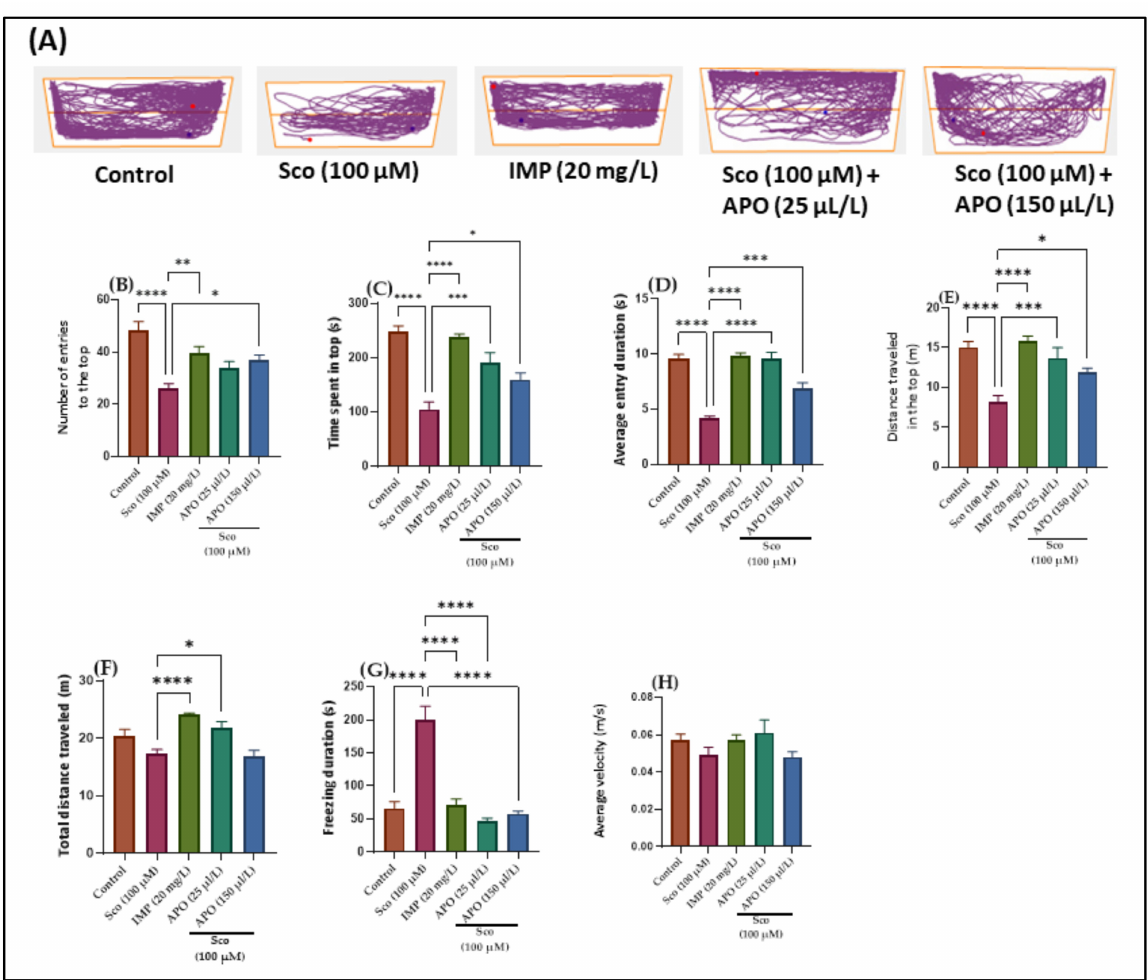
Figure 1. NTT results for Angelica purpurascens essential oil (APO: 25 and 150 µ L/L). ( A ) Repre- sentative tracking locomotion patterns; ( B ) Number of entries to the top; ( C ) Time spent in top (s); ( D ) Average entry duration (s); ( E ) Distance traveled in the top (m); ( F ) Total distance traveled (m); ( G ) Freezing duration (s); ( H ) Average velocity (s). Data are expressed as means ± S.E.M. ( n = 10). * p < 0.01, ** p < 0.001, *** p < 0.0001, and **** p < 0.00001 (Tukey’s post hoc analyses). Imipramine (IMP, 20 mg/L) was used as reference positive